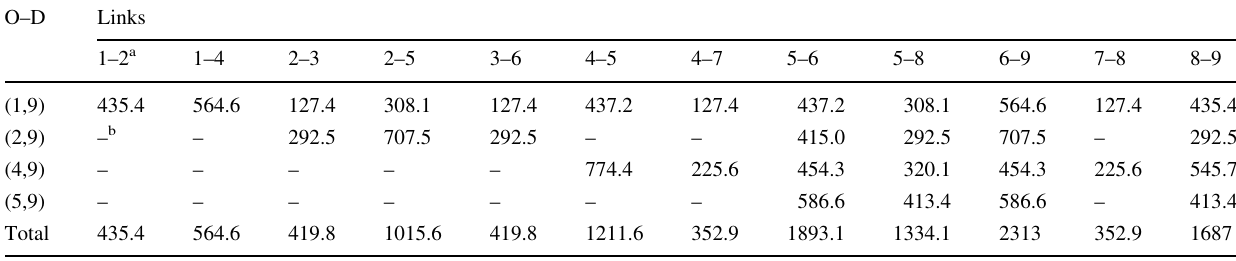
Table 3 Link flow assigned by O–D pairs and total link flow by the logit model O–D Links